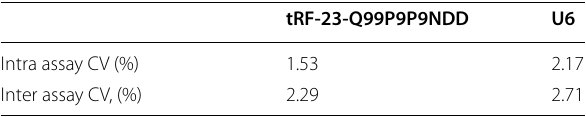
CV coefficient of variation